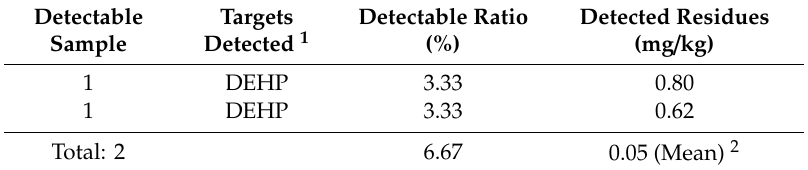
Table 2. Detection ratios of phthalates in pork samples (n = 30) collected during